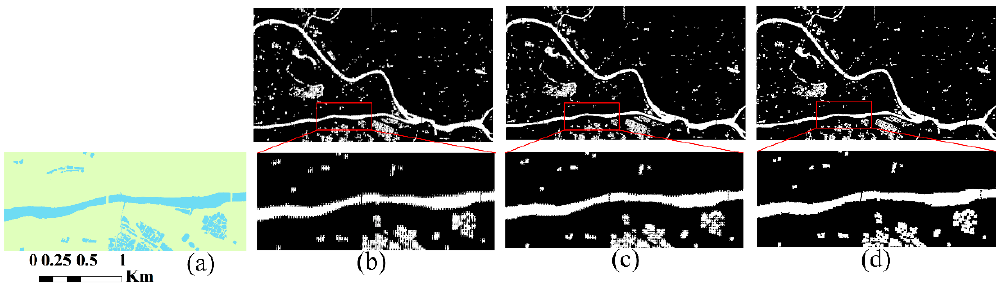
Figure 15. Subpixel water mapping results for Region C: ( a ) reference image; ( b ) SPM L ; ( c ) SPSAM; and ( d ) MSWM.